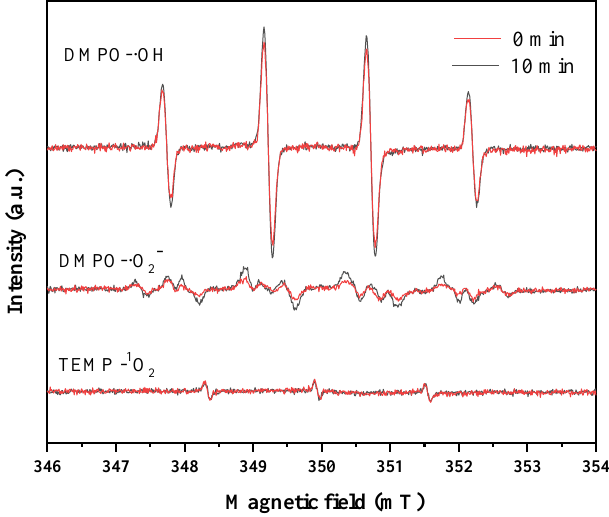
Figure 7. ESR spectra of DMPO- • OH in aqueous solution; DMPO- • O 2 − in methanol solution, and TEMP- 1 O 2 in aqueous solution.